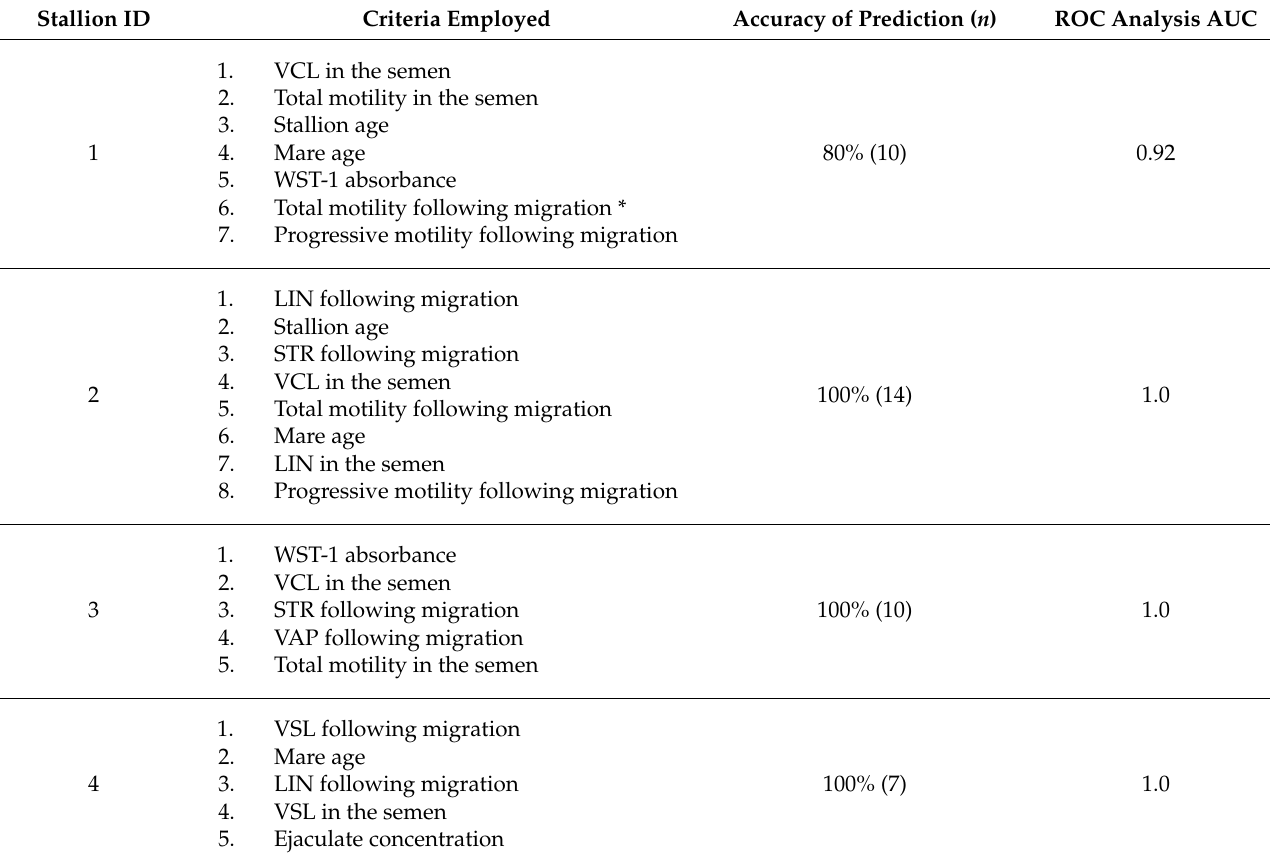
Table 3. Criteria employed to predict the success of insemination by stallion (analysis performed on semen